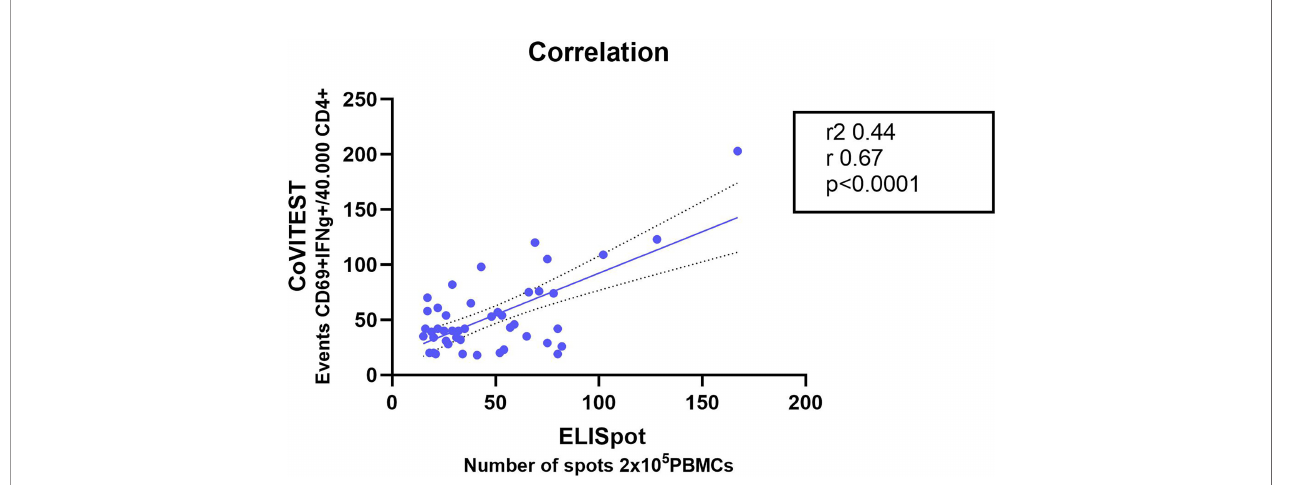
FIGURE 3 | Correlation of SARS-CoV-2-speci fi c T cell response from fresh whole blood CoVITEST with classic T cell IFN- g ELISpot Convalescent COVID-19 donors at two weeks, three and six months after the fi rst positive RT-PCR test. Linear regression analysis by comparing the number of CD4+ IFN- g + CD69+ T cells from whole blood with speci fi c T cells quanti fi ed by IFN- g ELISpot (n =